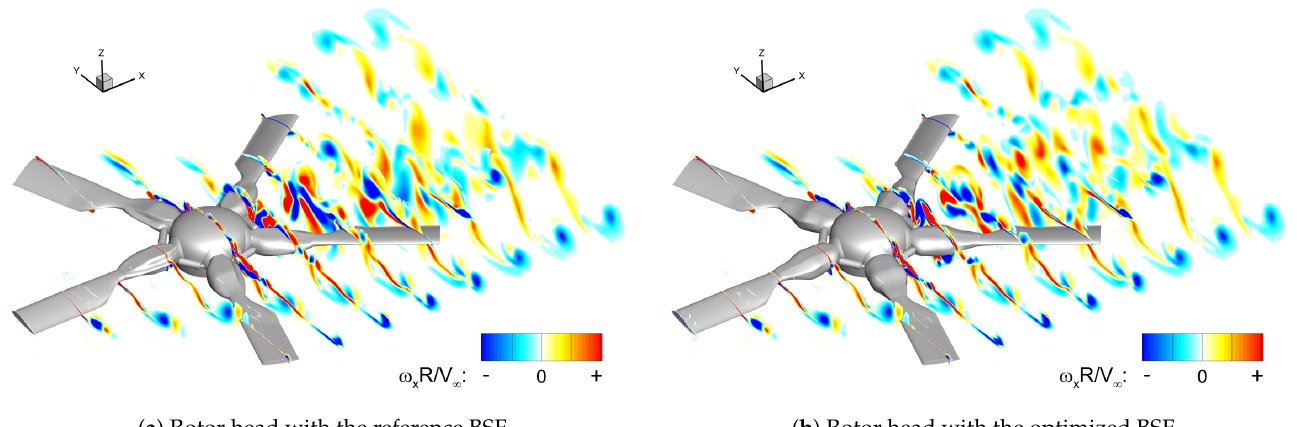
Figure 22. Normalized axial vorticity ω x · R / V ∞ shown in ten equally spaced slices along the flow direction.